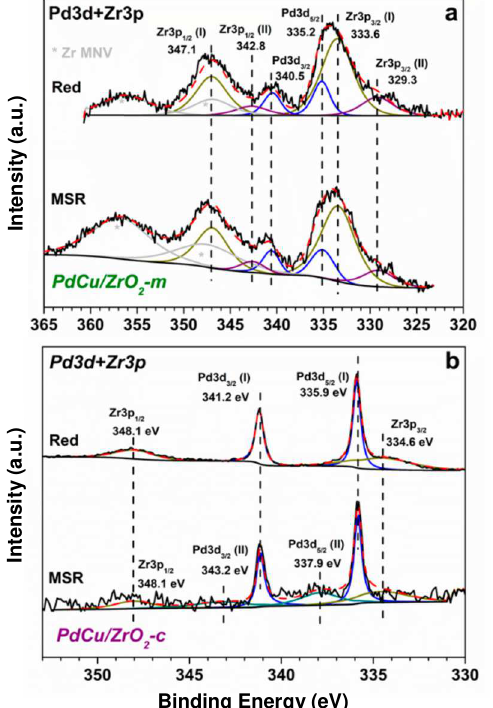
Fig. 2 . Pd3d+Zr3p core levels acquired with h ν =500eV in reducing and MSR conditions in monoclinic (a) and cubic (b) ZrO 2 supported catalysts. Reproduced from